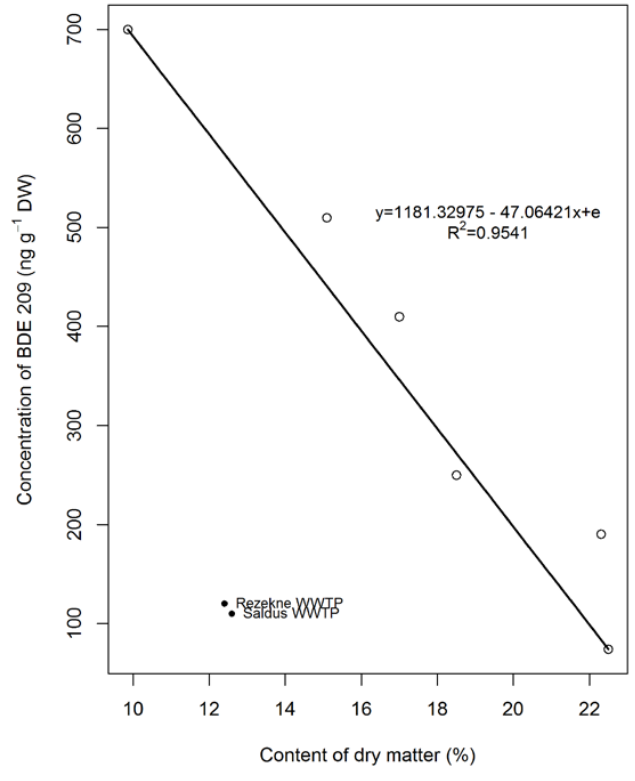
Figure 2. Linear regression curve of BDE 209 concentrations with the sewage sludge content of dry matter.